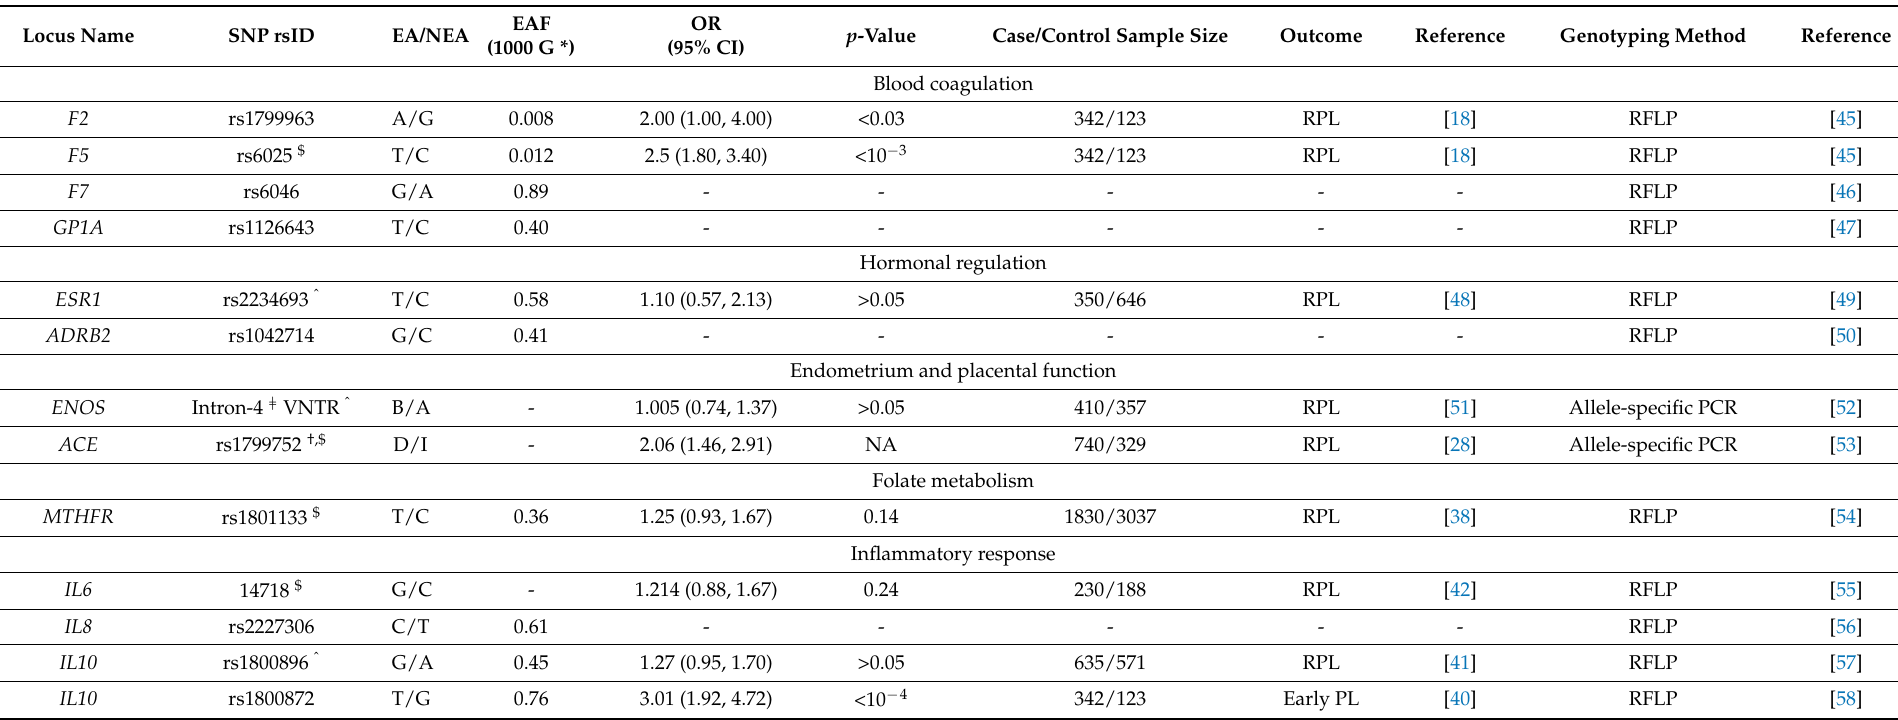
Table 1. Genetic variants used to assess their effect on the risk of RPL in the REPLIK